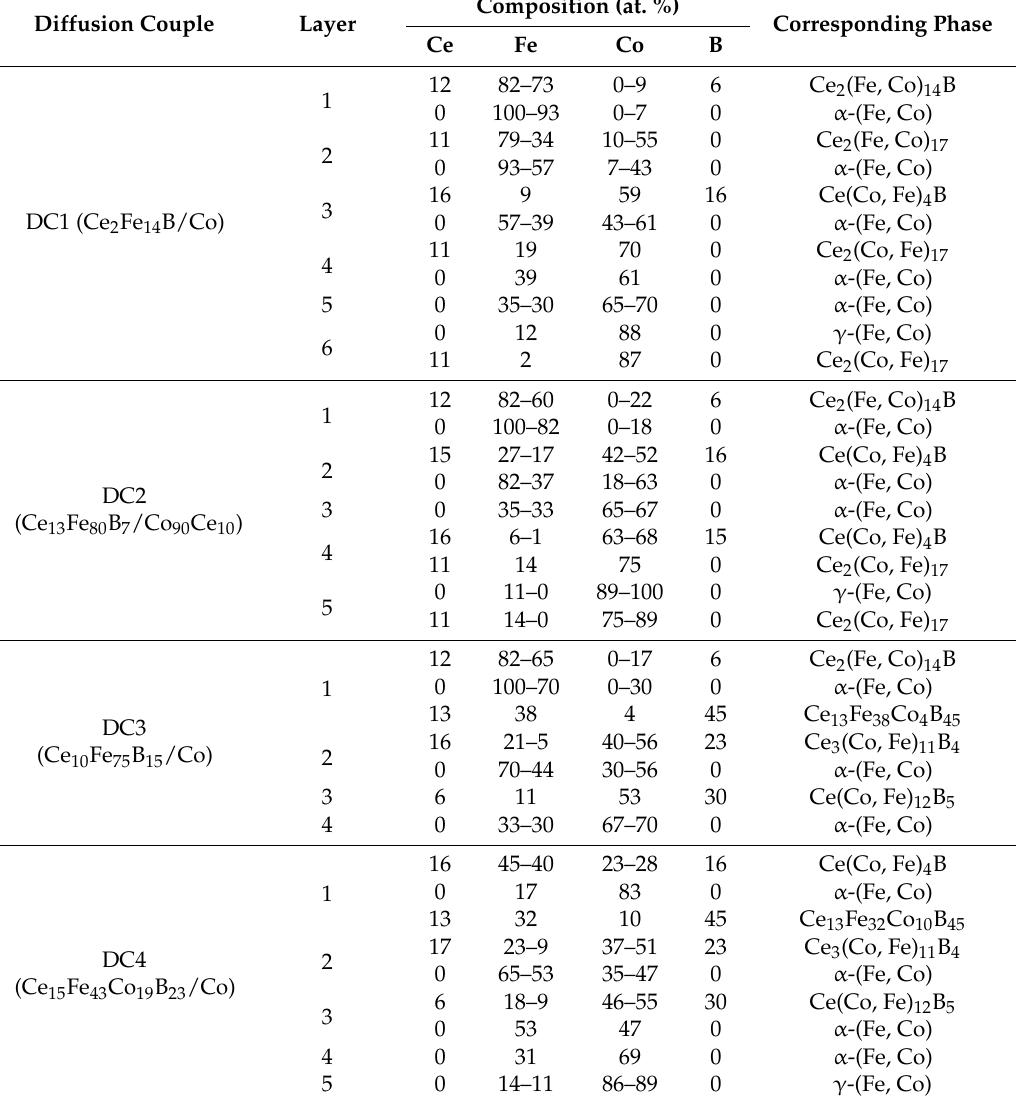
Diffusion Couple